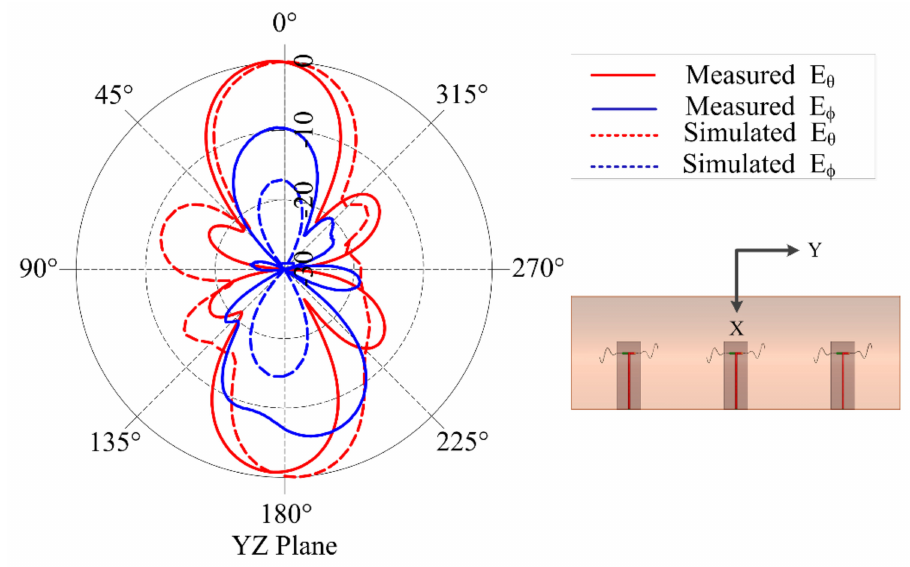
Figure 9. Radiation pattern of multi-element SEVA-CLA for an antenna array with 0 ◦ relative phasing at 824 MHz.